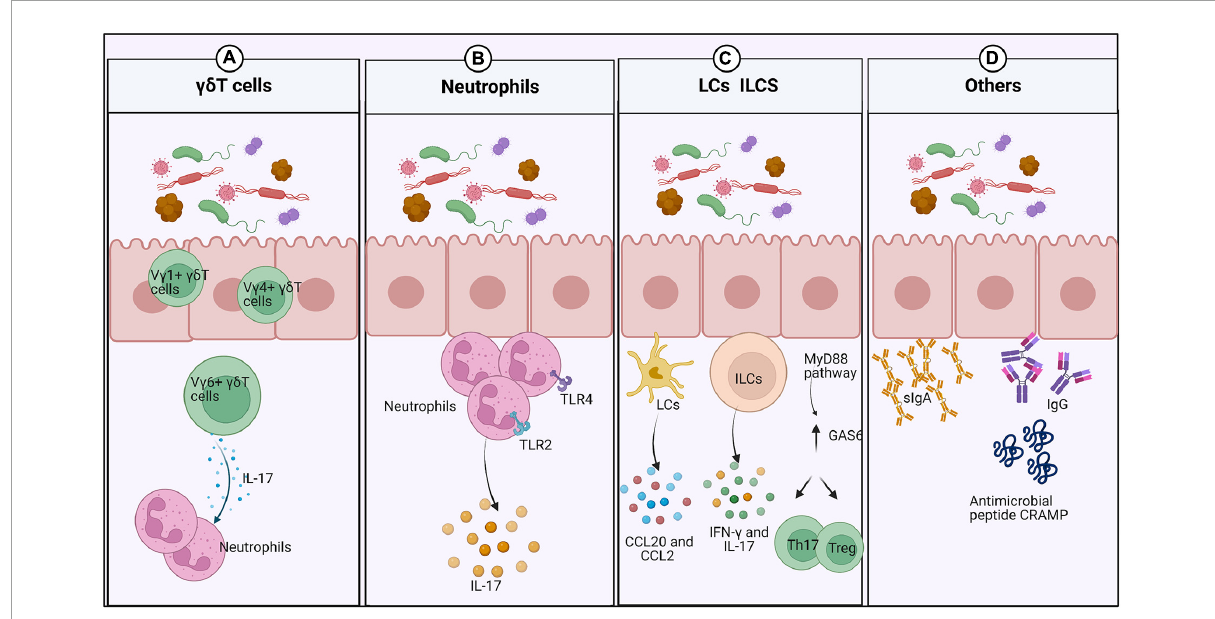
FIGURE1 Interplay between the oral mucosal immune system and the microbiota under normal conditions. (A) After exposure to the external microbiota, numerous innate lymphocytes expand into the oral mucosa. γδ dT cells increase rapidly in abundance and recruit neutrophils by producing IL-17. (B) Neutrophils increase in response to the local microbiota and IL-17 in the neonatal epithelium, but depend only on IL-17 in the gingiva. (C) Oral ILCs produce IFN- γ and IL-17 to protect the oral mucosa from viral and fungal infection. LCs are recruited by CCL20 and CCL2 to maintain mucosal homeostasis and prevent tissue destruction. In response to oral microbes, expression of GAS6 is upregulated in the gingival epithelium to maintain microbial homeostasis and downregulate gingival inflammation. (D) The oral microbiota promotes the induction of salivary antimicrobial components such as IgA and antimicrobial